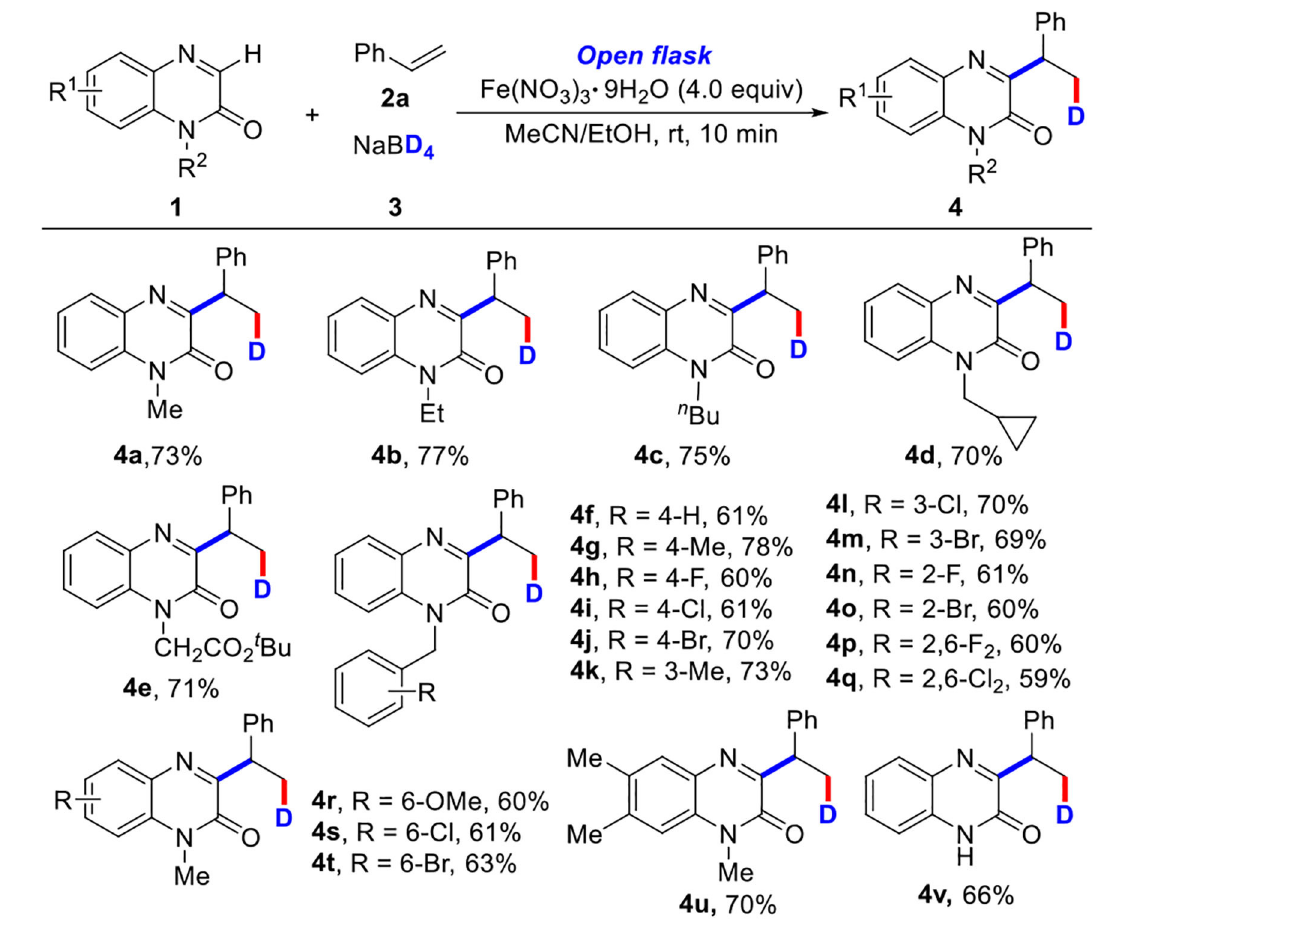
TABLE 2 | Substrate scope of quinoxalinones a,b